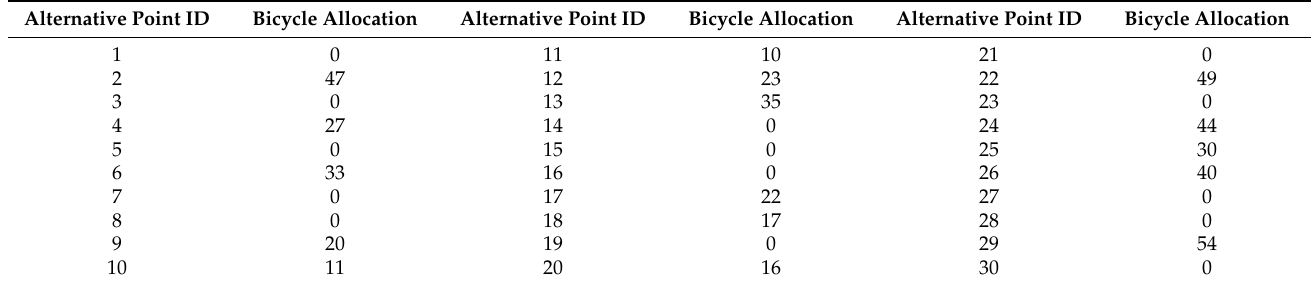
Figure 7. The optimized layout scheme of bike-sharing facilities. Table 3. The first-generation scheme and the number of shared bikes allocated. Table 4. The optimal scheme and the number of shared bikes allocated.